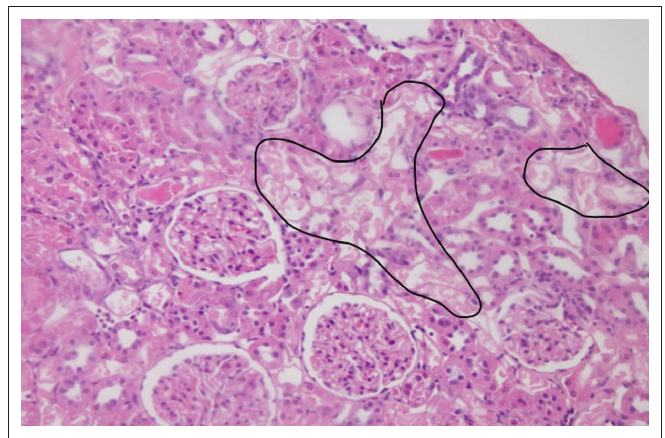
Figure 3. Light microscopic view of kidney of the GM + PS group, where areas of severe tubular necrosis (within the marked area) are seen (H&E, × 200). H&E, hematoxylin and eosin; GM + PS,